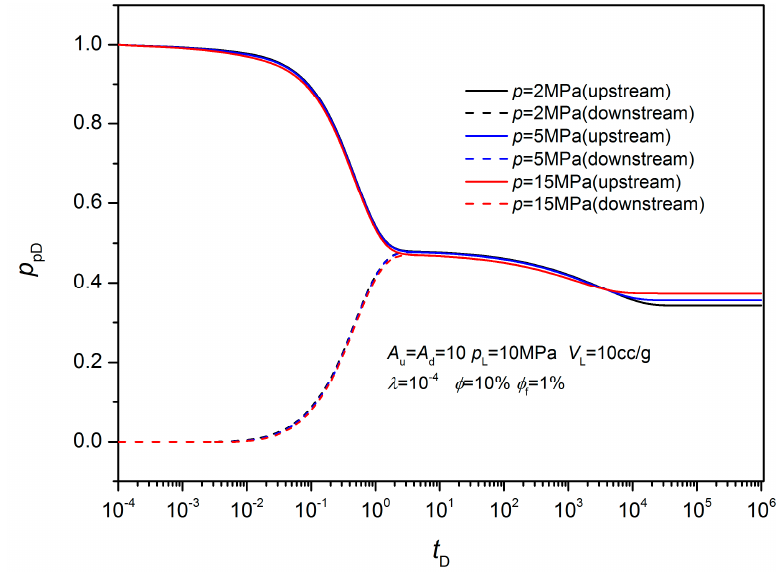
Figure 7. The influence of the testing pressure on the curve of the non-equilibrium sorption model.